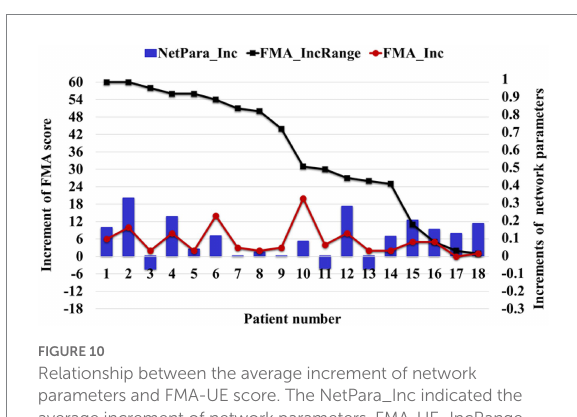
FIGURE 10 Relationship between the average increment of network parameters and FMA-UE score. The NetPara_Inc indicated the average increment of network parameters, FMA-UE_IncRange indicated the increment range of the FMA-UE score, and FMA- UE_Inc indicated the actual increment of the FMA-UE score.